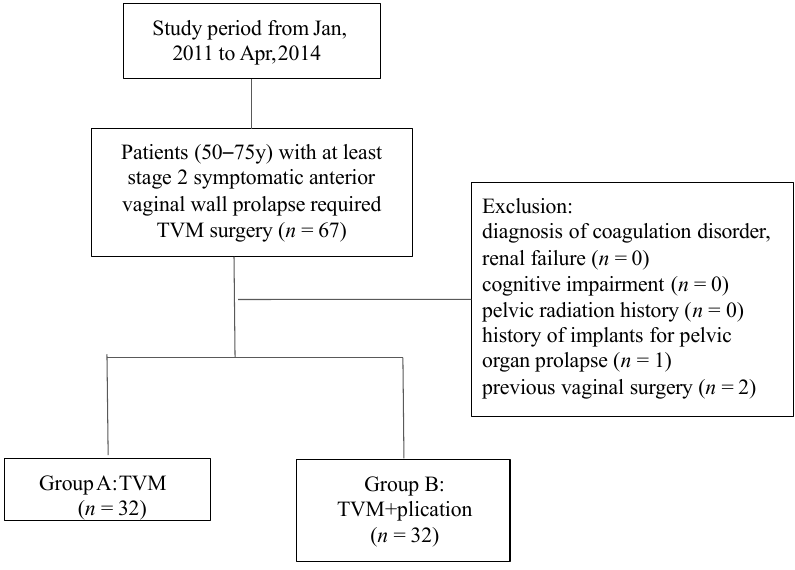
Figure 1. Study flow chart. TVM: transvaginal mesh.